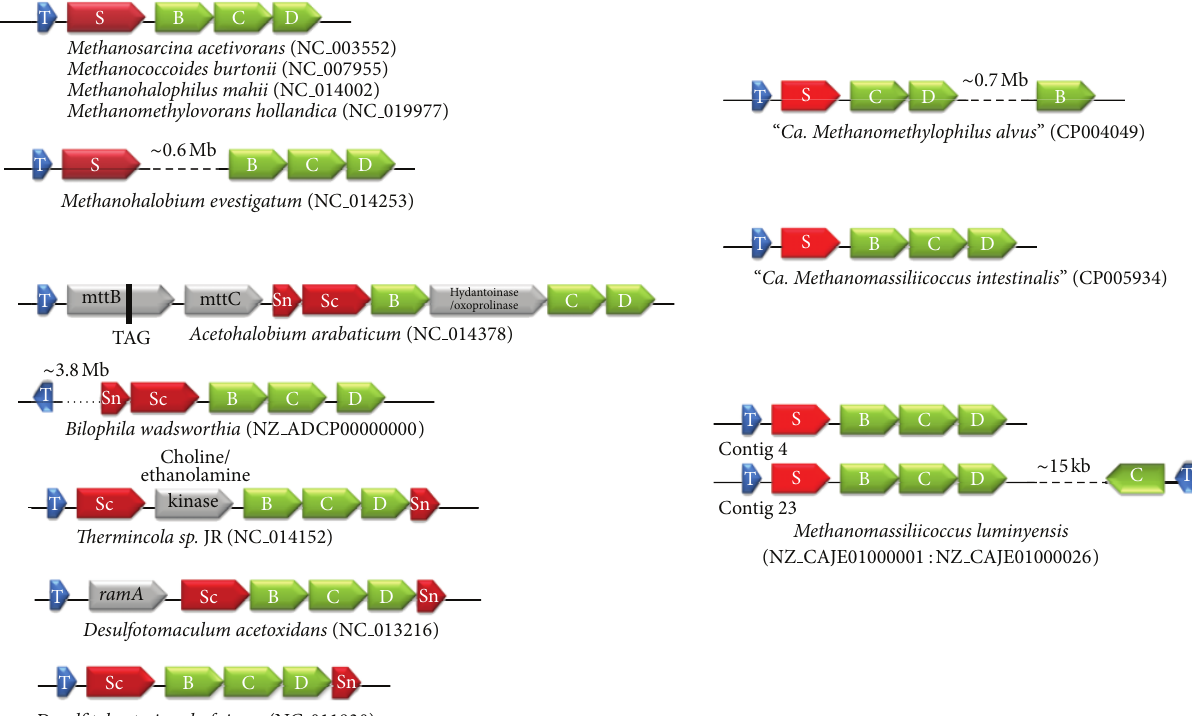
Figure 1: Gene organization of the Pyl system. On the left, the gene organization of the pylBCD and pylS ( pylSc and pylSn in bacteria) is shown for Methanosarcinaceae and some representative bacteria (adapted and updated from [11, 13, 53]). On the right is shown the organization of these genes in the 7th order of